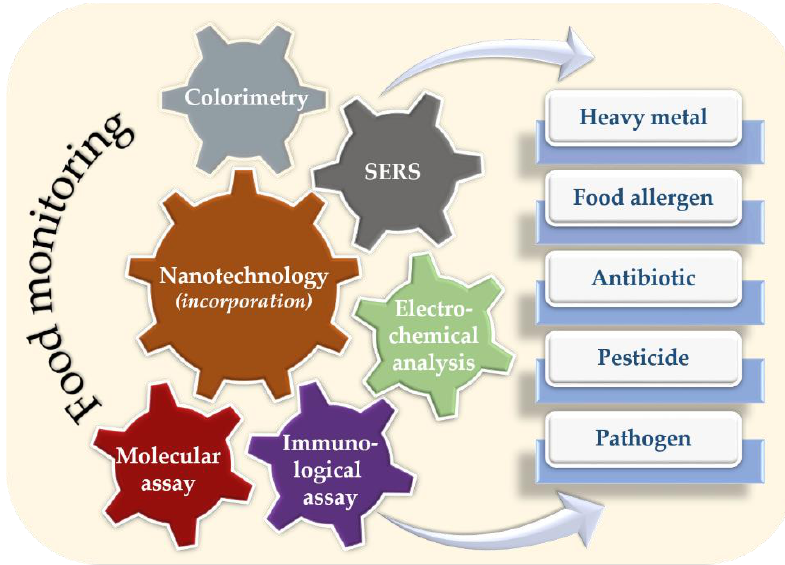
Figure 1. Application of nanotechnology for the monitoring of food